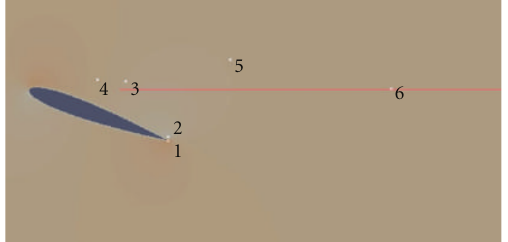
Figure 1: Computational domain and location of probes.